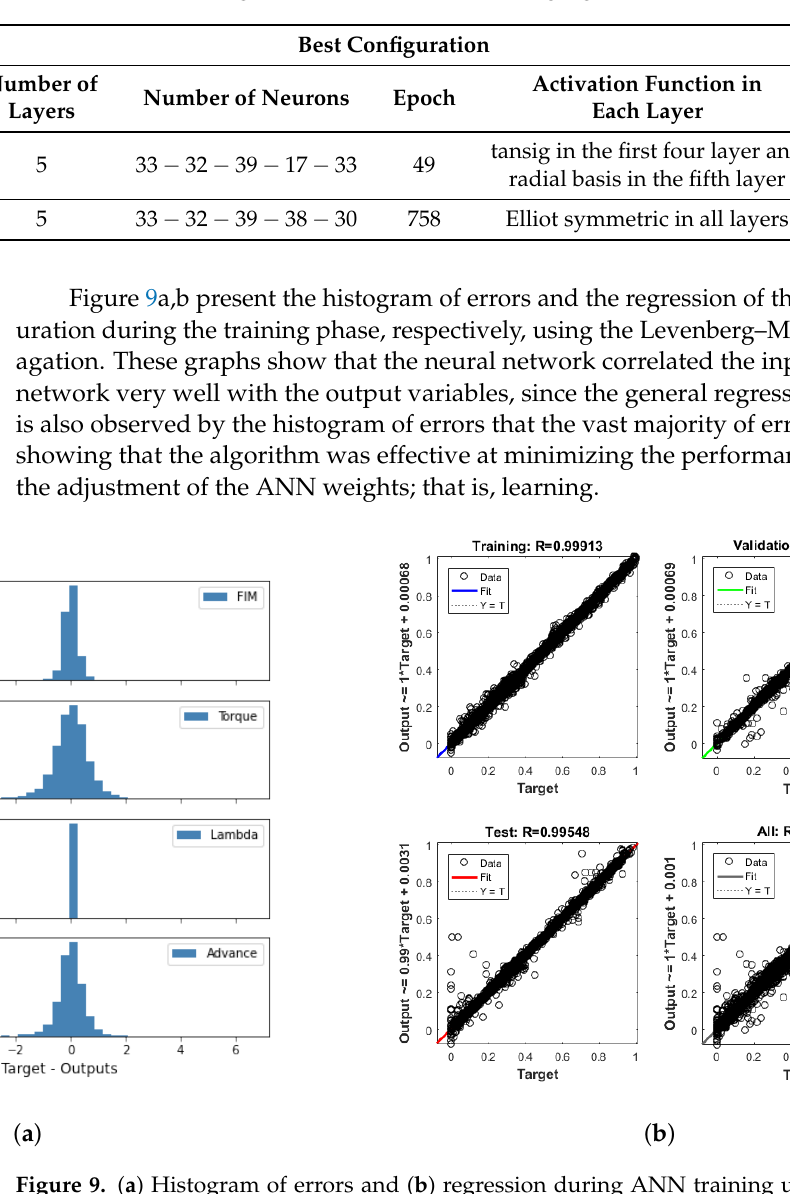
Table 5. The best configuration found for each training algorithm.